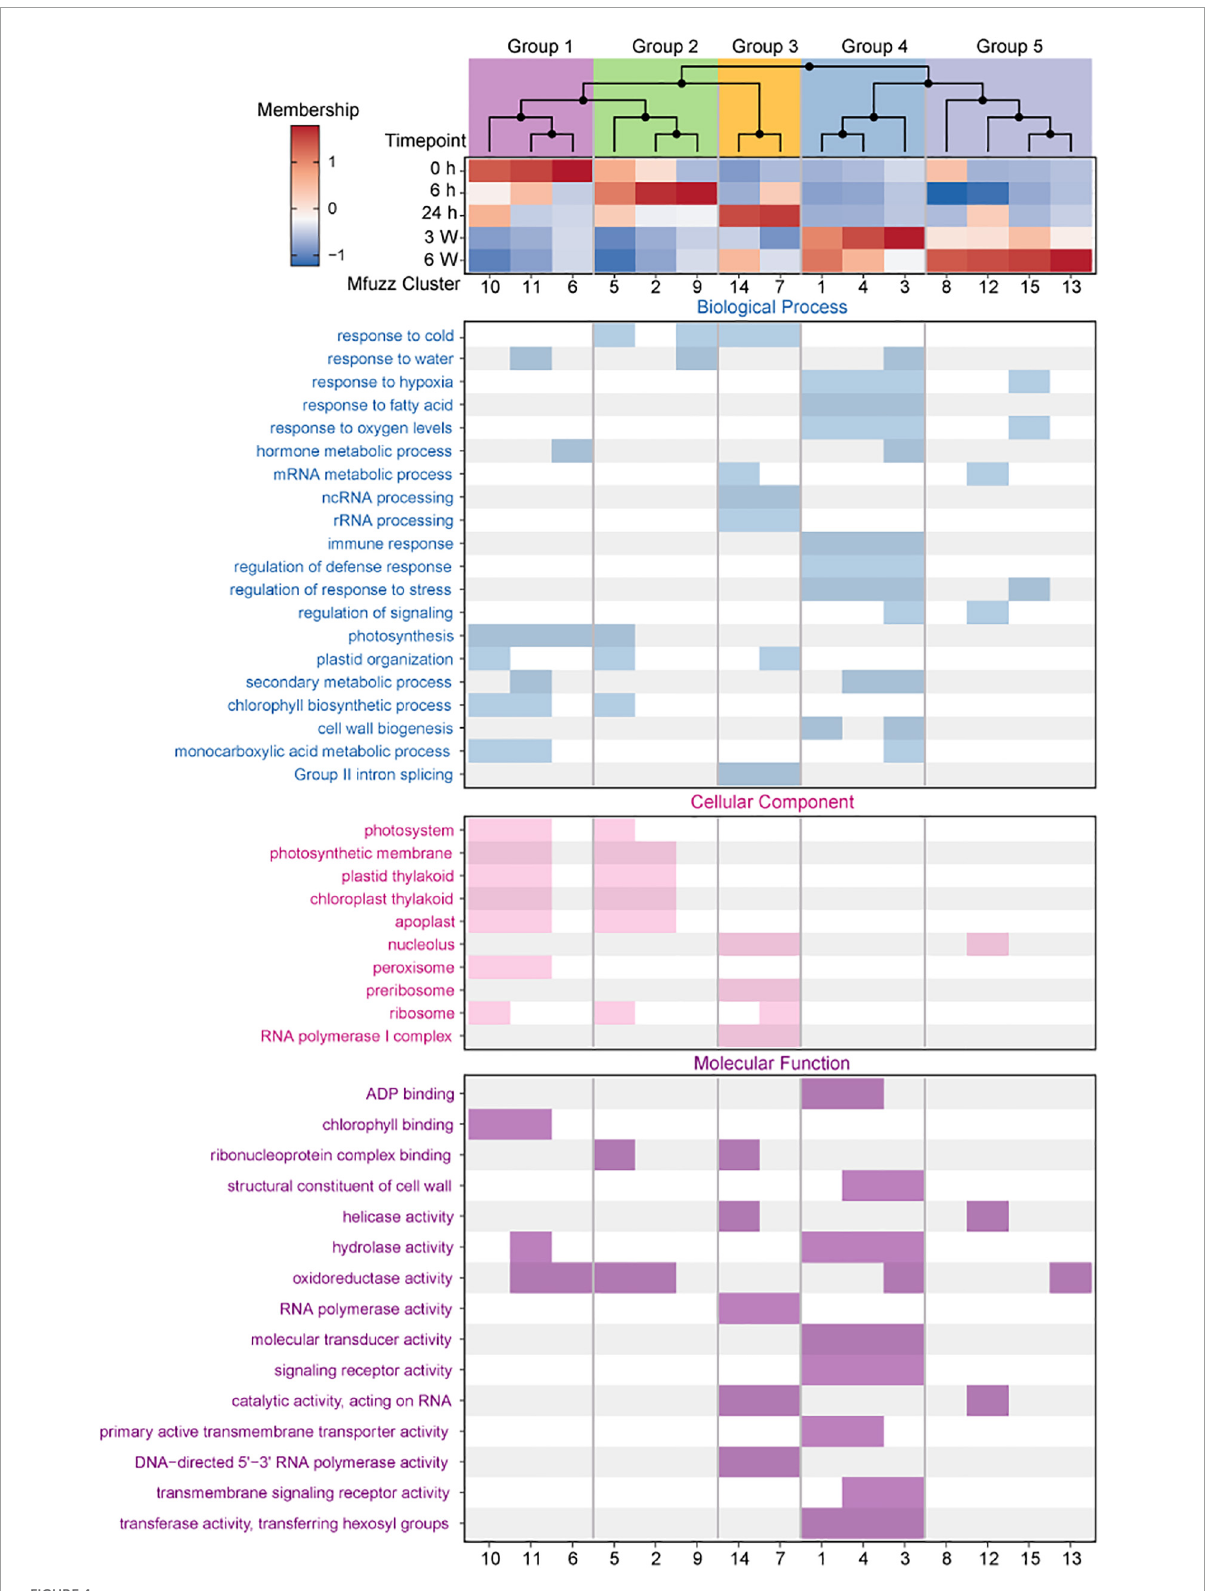
FIGURE4 Expression dynamics reveal a temporal ordering of biological processes during cold treatment. (Top) Hierarchical clustering and heat map of Mfuzz cluster core expression profiles. (Bottom) GO enrichment analysis with clusterProfiler.